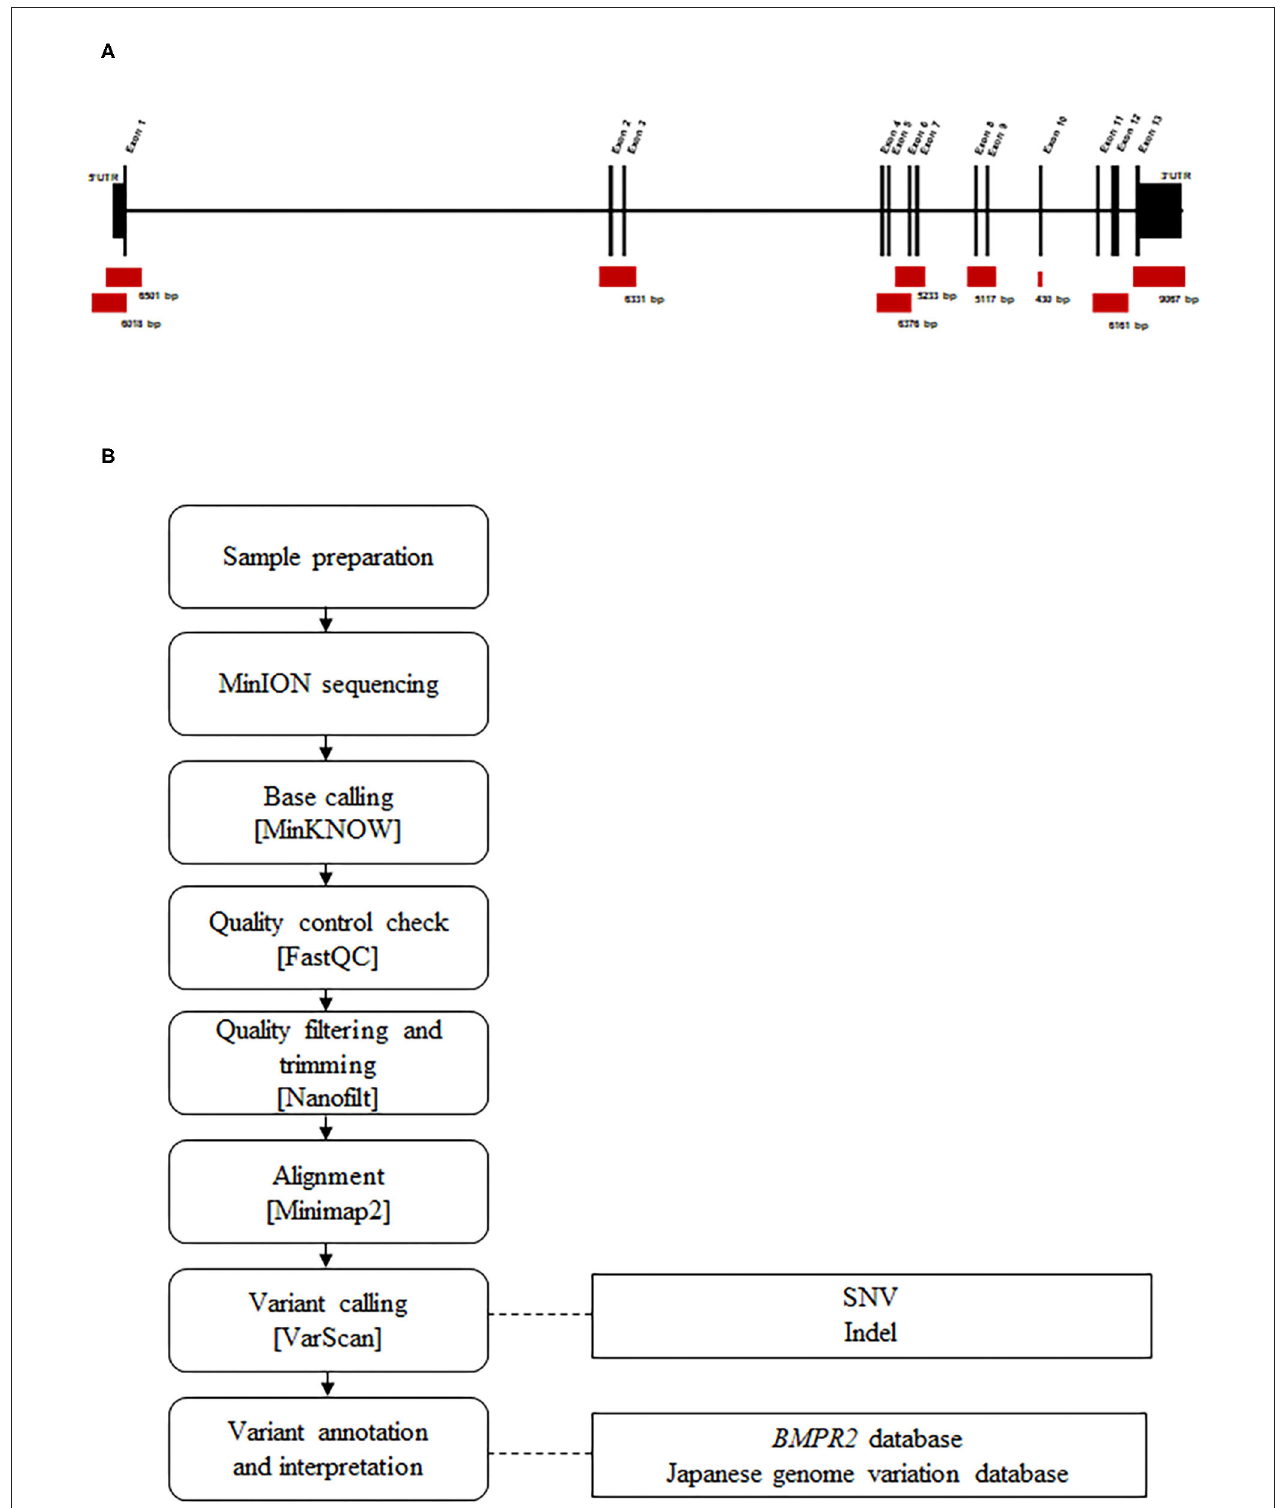
FIGURE 1 | Design and workflow of the BMPR2 targeted MinION sequencing process. (A) Representation of the BMPR2 genomic structure and location of the primer sets used for long-PCR amplification. (B) Sequencing workflow and the custom bioinformatics pipeline.